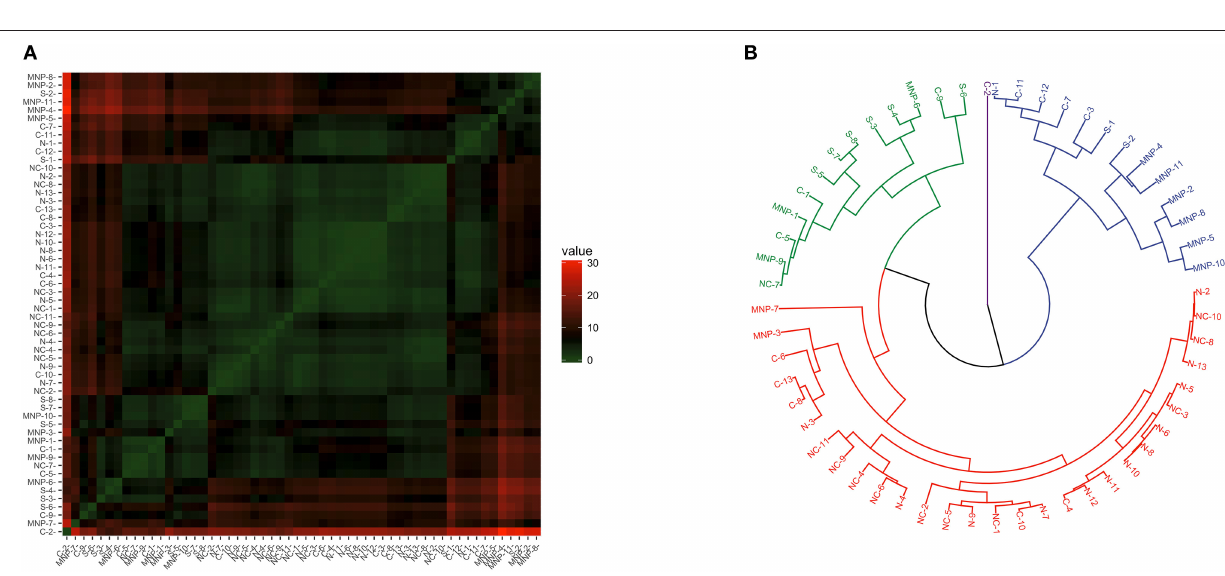
0.036, Figure 7D . The pattern was consistent and contrasting between viruses. Namely, sea lions infected by OtHV-1 had transcription levels similar to or lower than those of non-